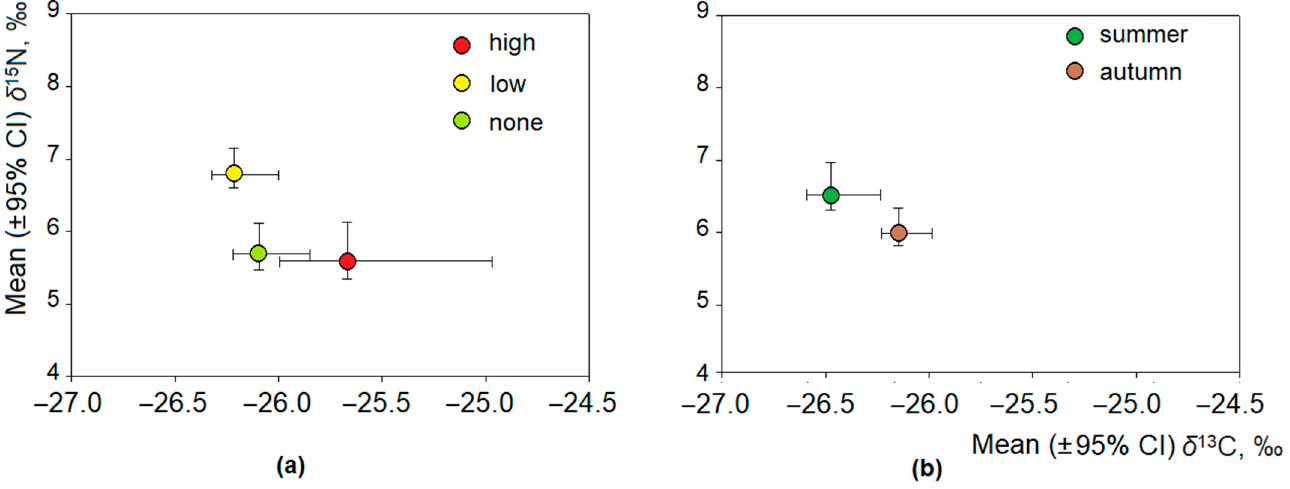
Figure 4. Position of C. glareolus according to stable isotope ratios: ( a ) depending on the intensity of agricultural treatment; ( b ) in different seasons.